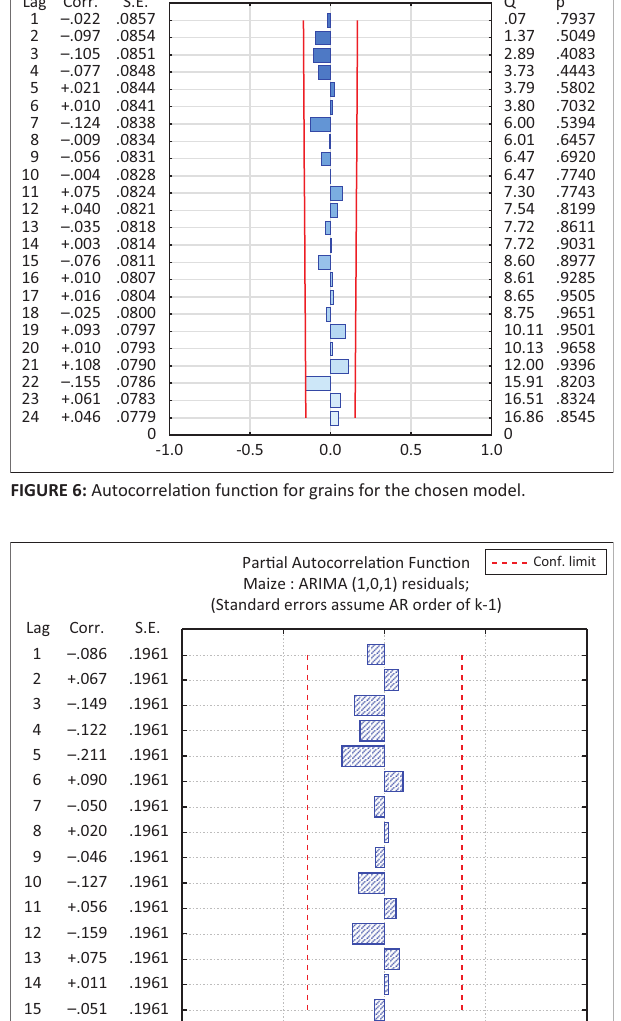
Autocorrela(cid:22)on Func(cid:22)on Grains : D(-1); ARIMA (2,0,0) residuals; (Standard errors are white-noise es(cid:22)mates)